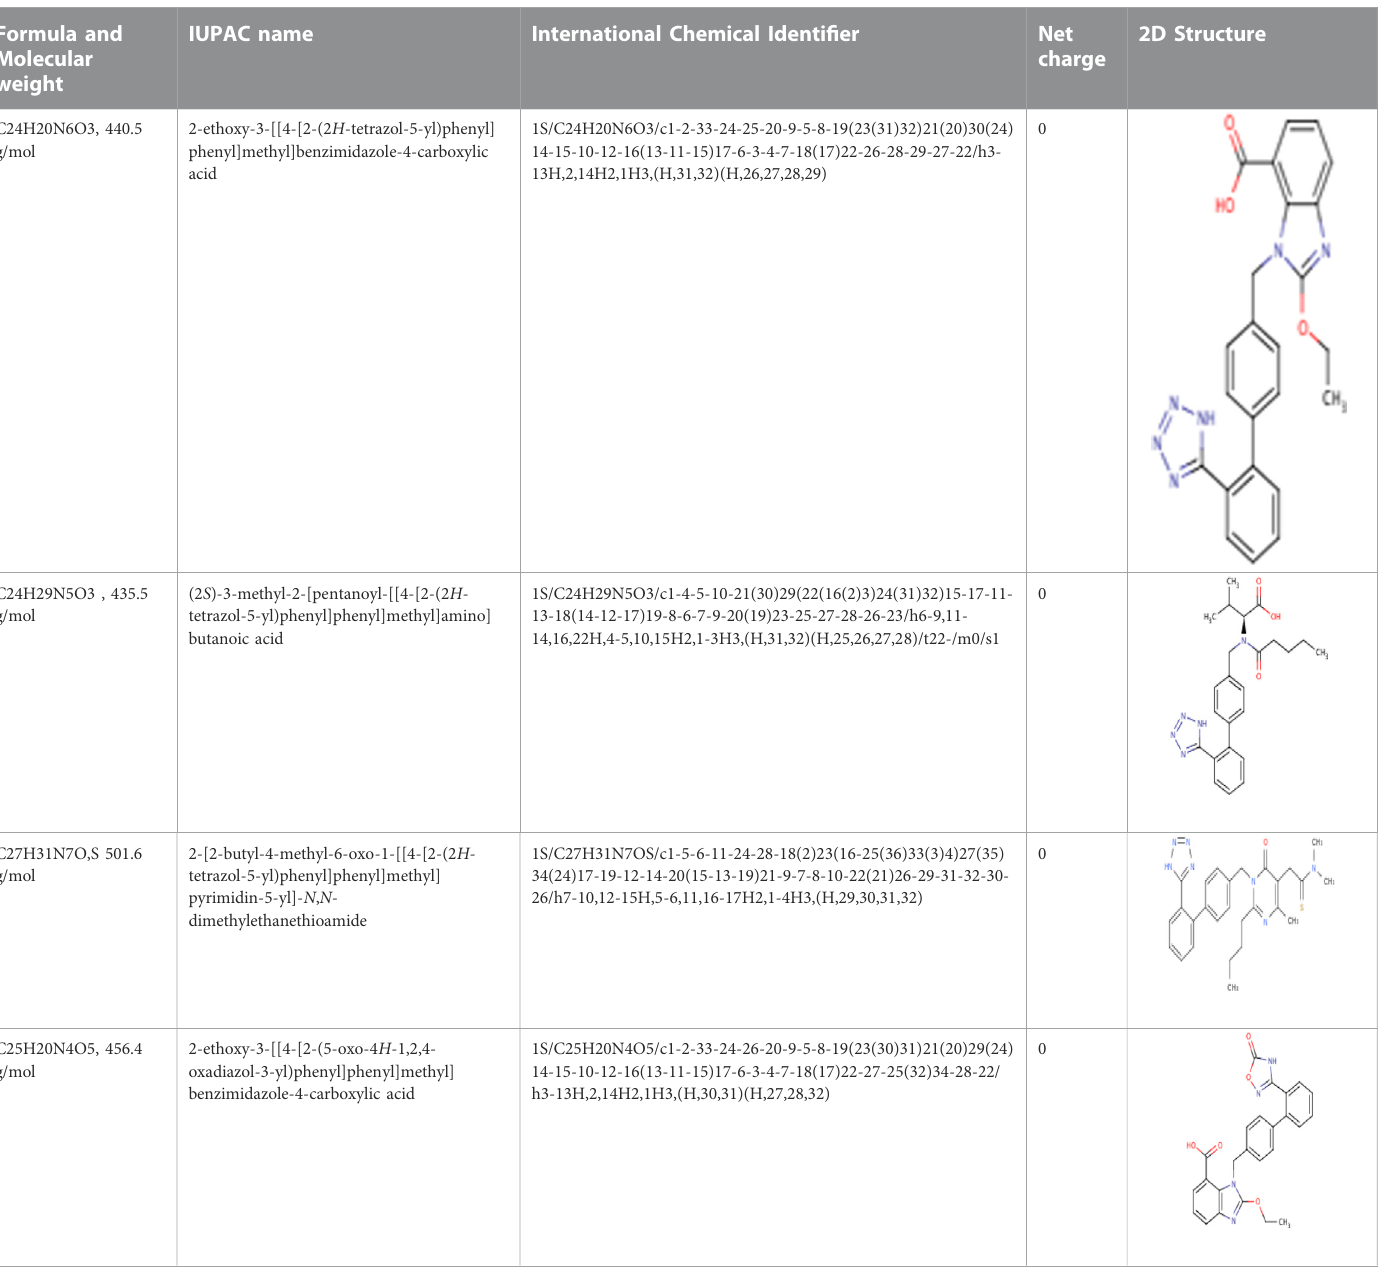
TABLE 2 ( Continued ) Molecular structural details of RAAS inhibitors (Ref: